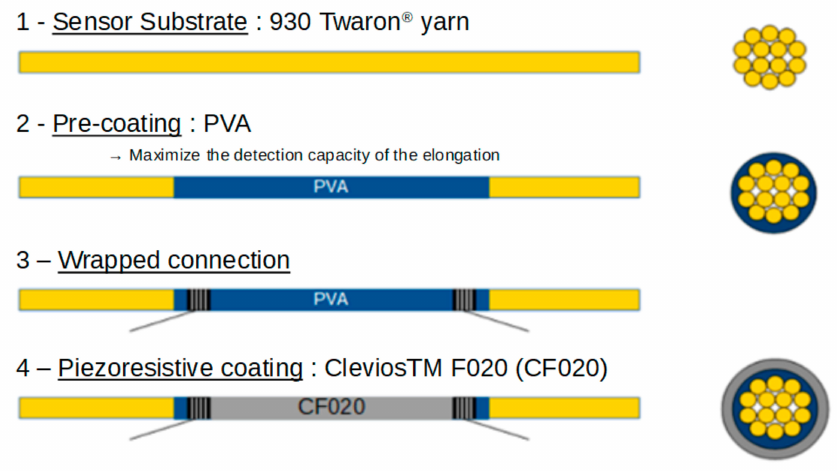
Figure 1. Different steps allowing for the realisation of piezoresistive sensor yarns: profile views (on the left ) and frontal views (on the right